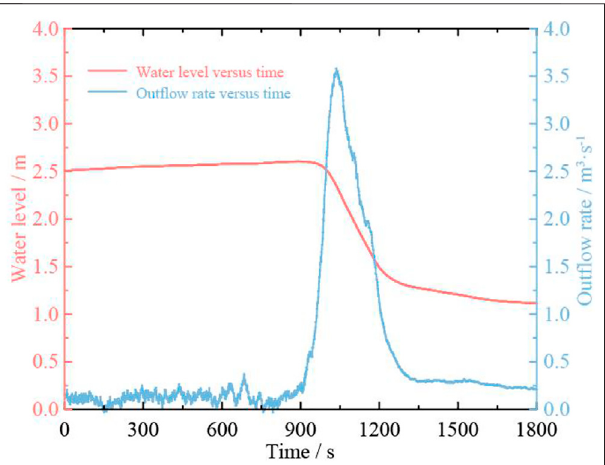
FIGURE 6 | Water level and discharge curve of Test No.